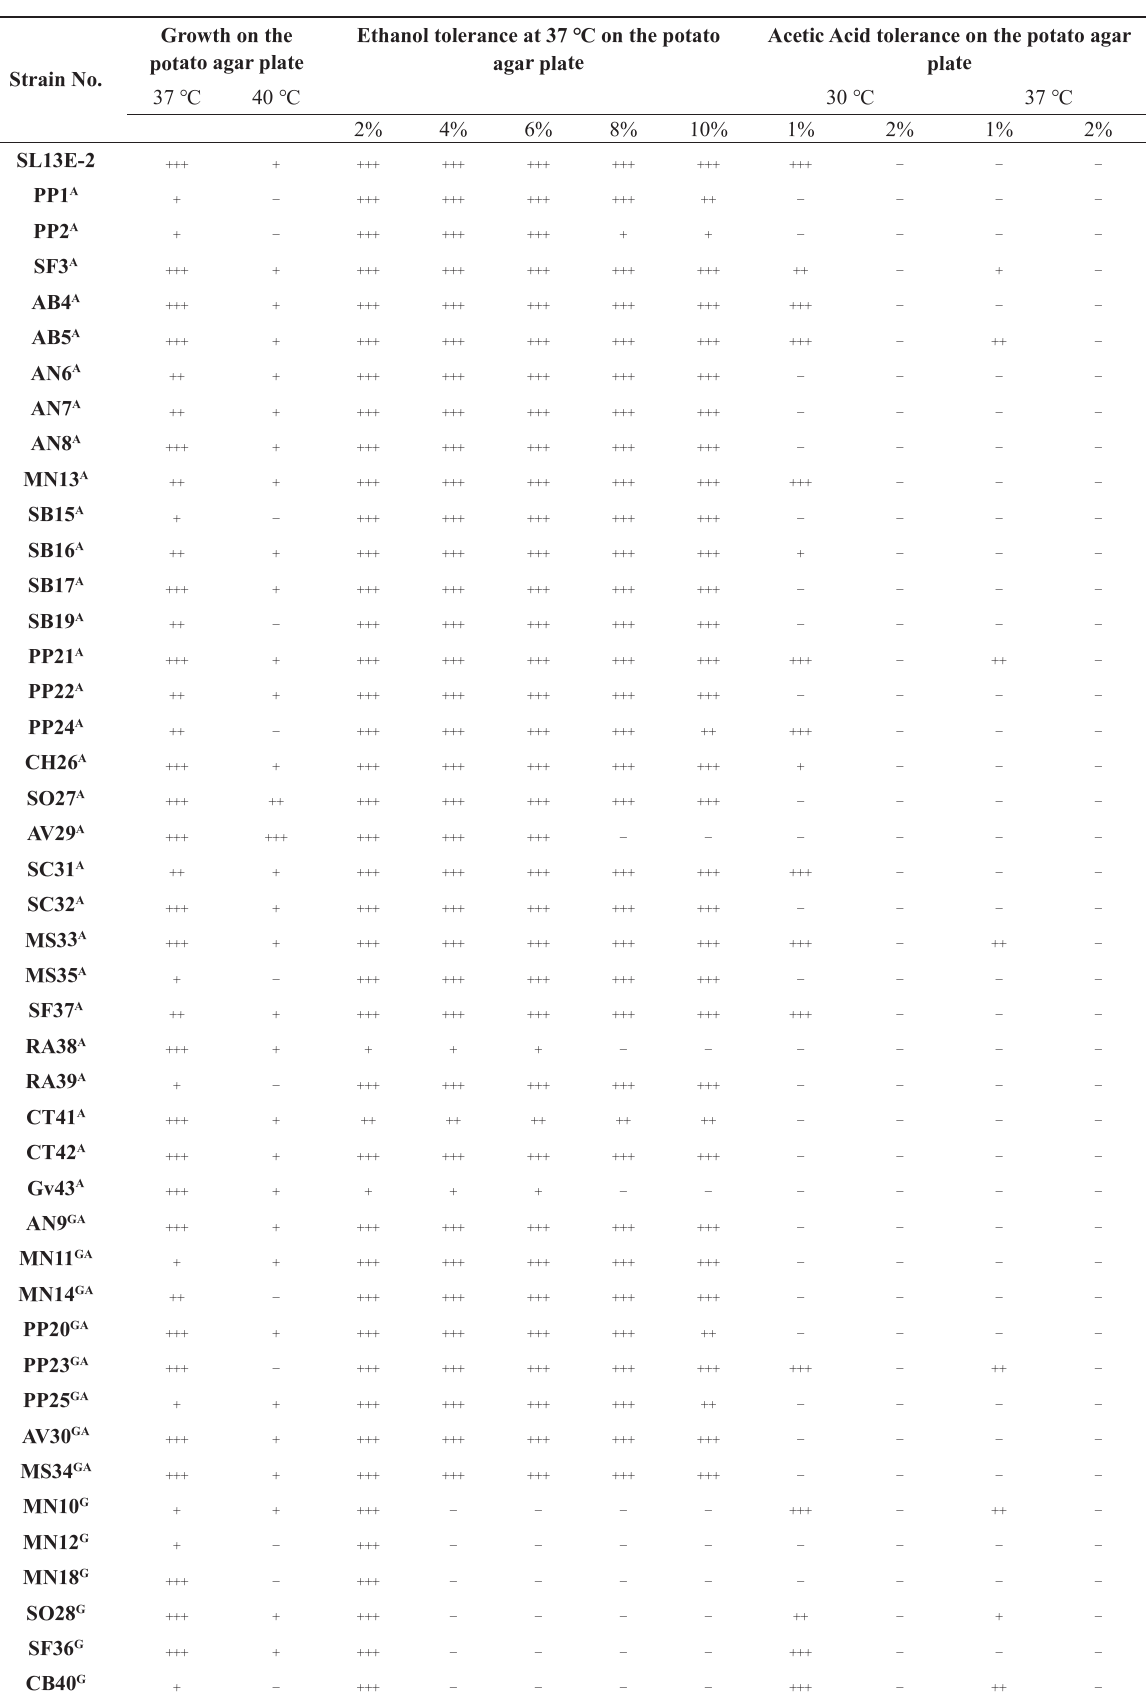
Table 4: Growth properties of isolated